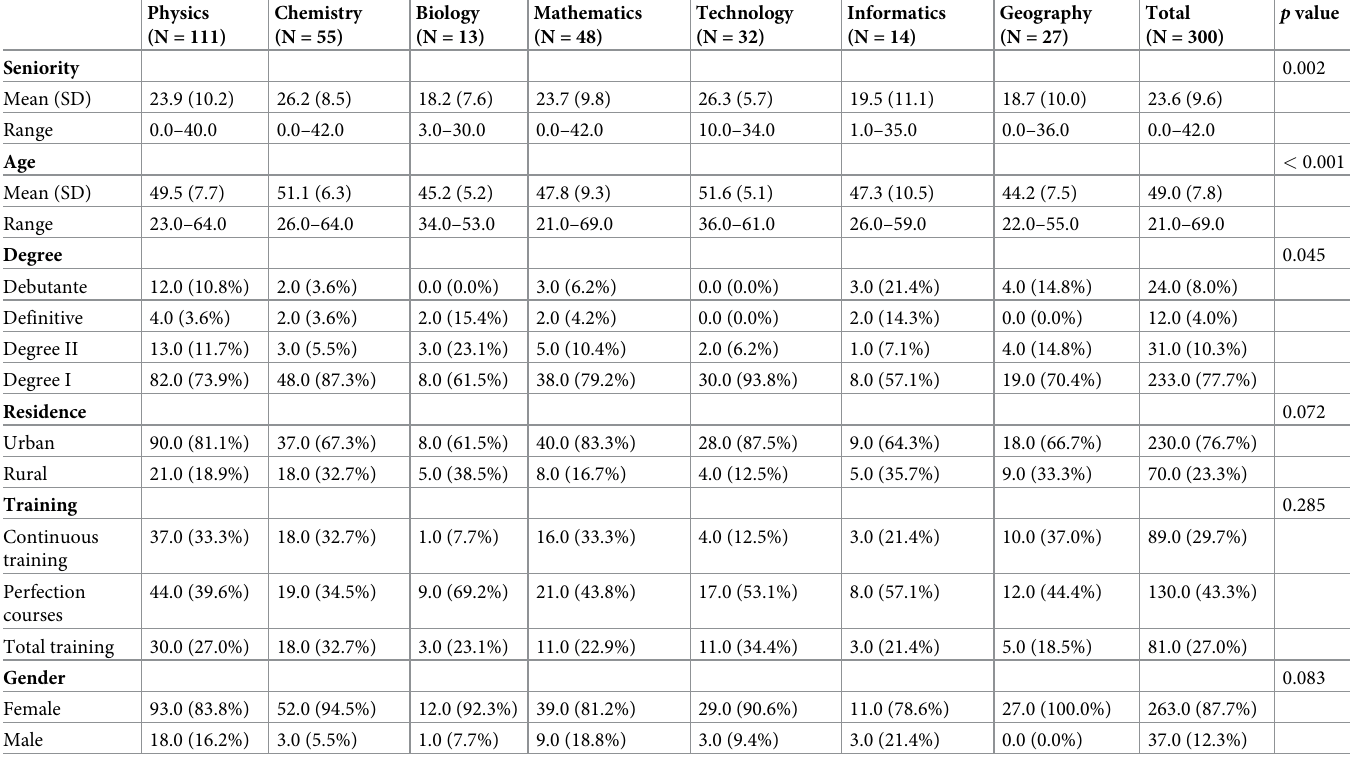
Table 1. Socio-demographic characteristics of the participants by